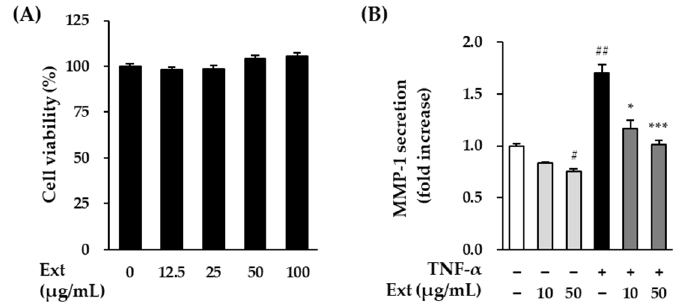
Figure 1. The effects of the hot water extract from the fruits of M. alba on HDFs cell viability ( A ) and MMP-1 secrection ( B ). ( A ) The cells were seeded on 96-well plate with the density of 1 × 10 4 cells/well and incubated for 24 h. Next, the cells were treated with indicated concentrations of sample for 24 h. The Ez-Cytox kit was used to assess the viability of the cells. ( B ) The cells were seeded on 48-well plate with the density of 2 × 10 4 cells/well and starved with non-serum media for 24 h. Next, before being exposed to 20 ng/mL TNF- α for 24 h, the cells were first given the relevant sample concentrations to use for 1 h. The MMP-1 secretion in supernatants were determined using ELISA kit. The data were described as mean ± SEM. # p < 0.05 and ## p < 0.01 non-treatment group versus TNF- α treatment group. * p < 0.05 and *** p < 0.001 extract treatment group versus TNF- α treatment group.